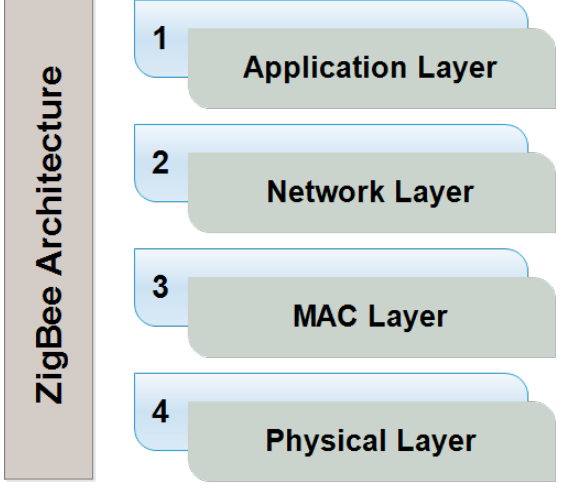
Figure 7. The architectures of